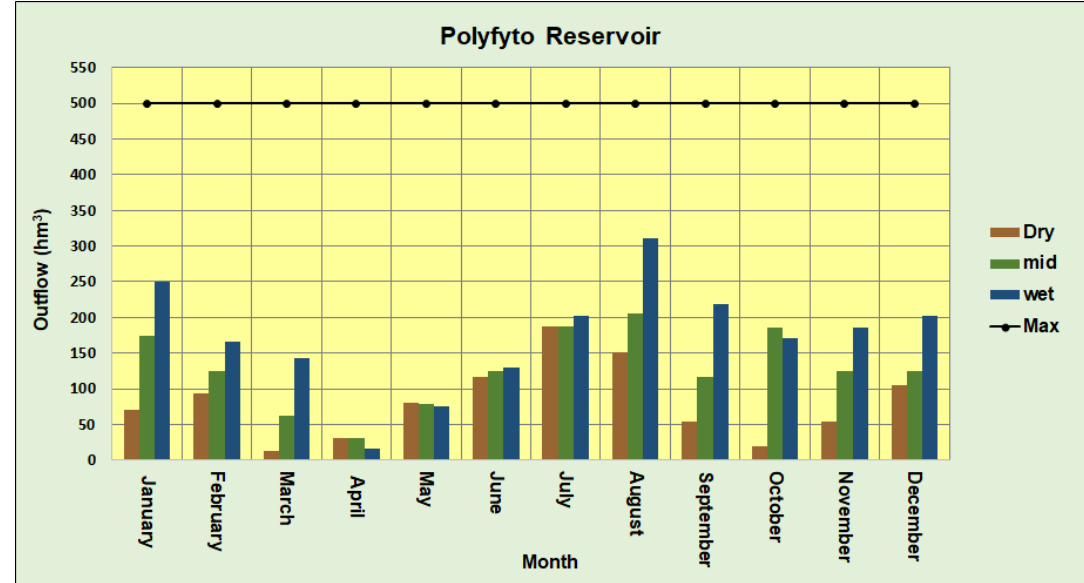
Figure 14. The optimal outflows for the current state of water resources demand, applying the institutional operating rule curves for Polyfyto reservoir. Energies 2020 , 12 , x FOR PEER REVIEW 18 of 22